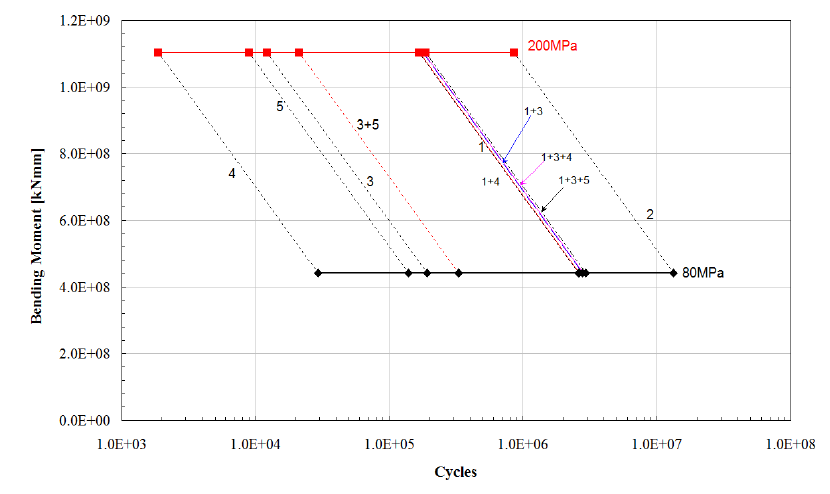
Figure 29: Bending moment (amplitude) vs. fatigue life for various